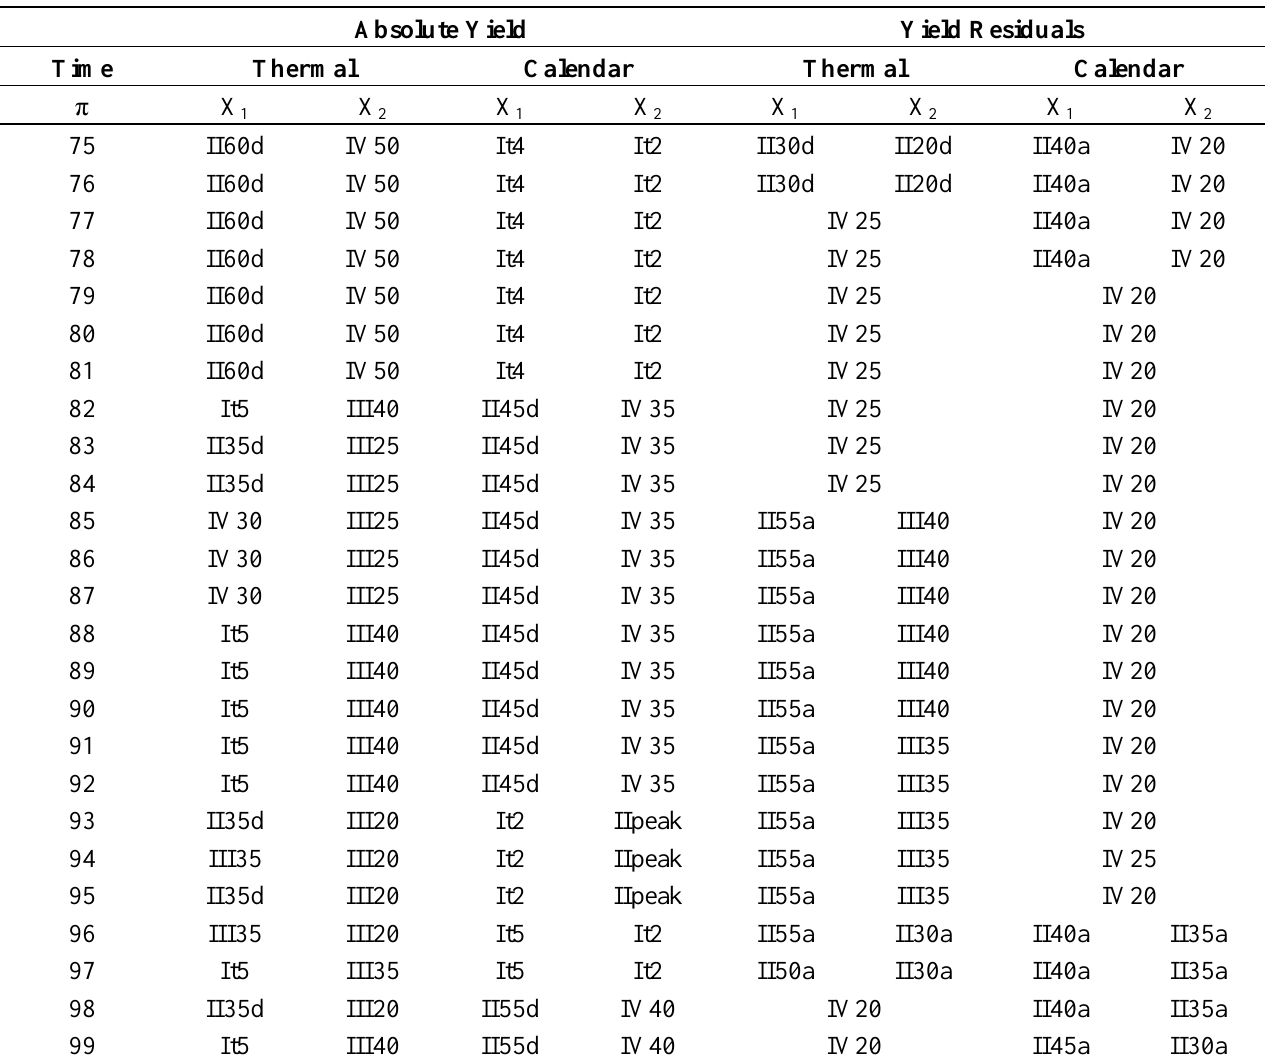
Table 2. Metric(s) that are significantly related ( p- value < 0.05) to either absolute yield or yield residues, and that provide the lowest RMSE for increasing spatial purity (π) thresholds. The value of the RMSE and R 2 can be read from Figure 10. A maximum of adj two metrics ( X and X ) can be selected. For clarity purposes, the nomenclature of the 1 2 metrics was abbreviated by removing the word ‘ Type